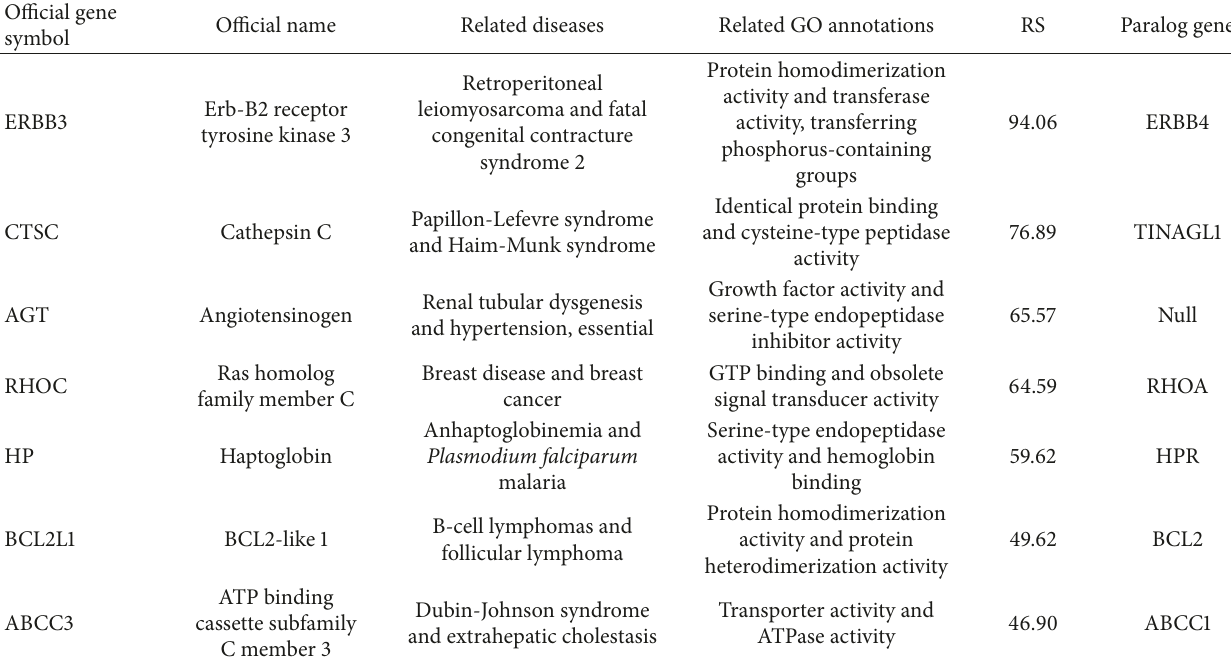
Table 7: Unique co-differentially expressed genes by HDNMF (INTA